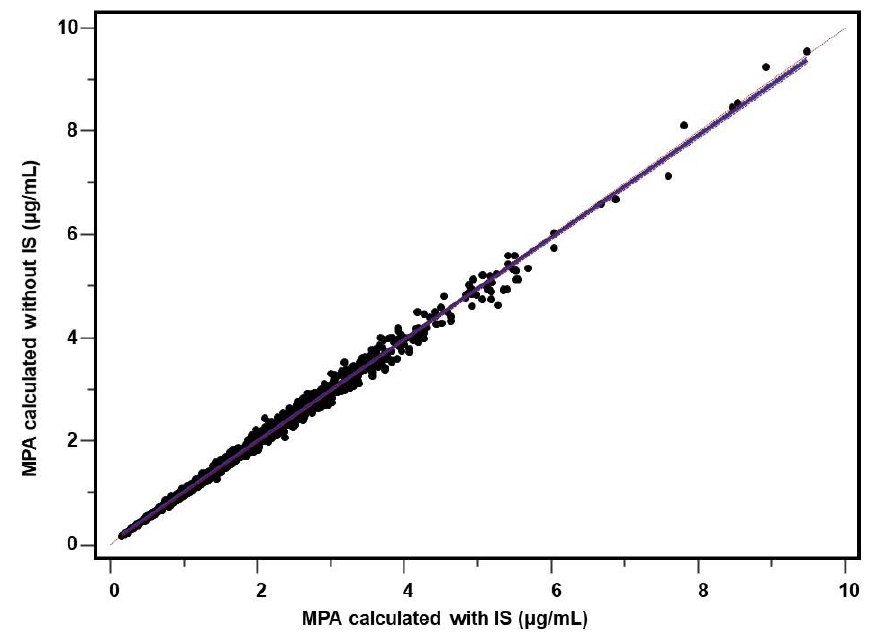
Figure 4. Comparison of calculation methods made on a total of 1187 samples from heart transplant patients. Passing–Bablok regression: y = 0.986x + 0.014 represents MPA concentrations ( µ g/mL) obtained without using IS against those obtained with using IS.